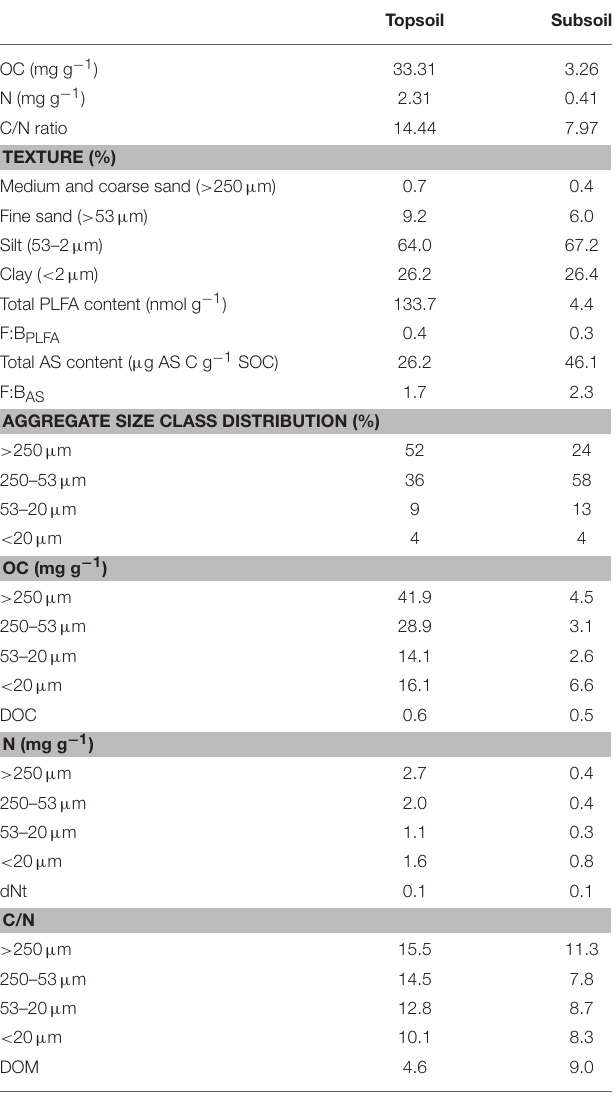
TABLE 1 | Basic soil properties of the soil material used for incubation (before